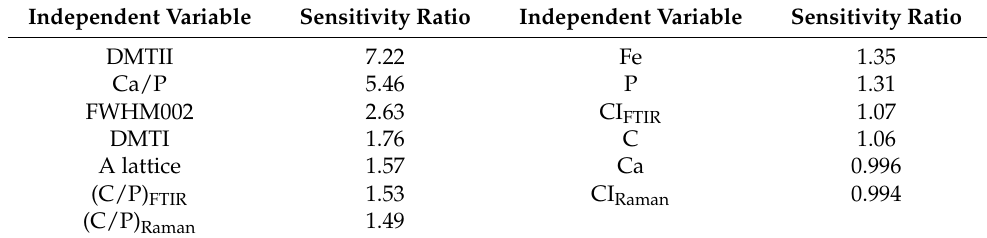
Table 2. Sensitivity analysis of inputs used in MLP network training. Independent Variable